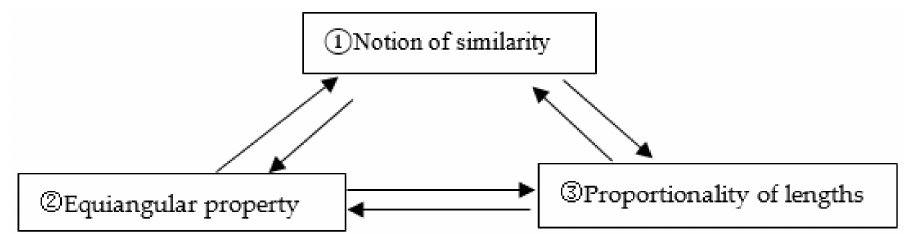
Figure 1. The properties of similarity and their